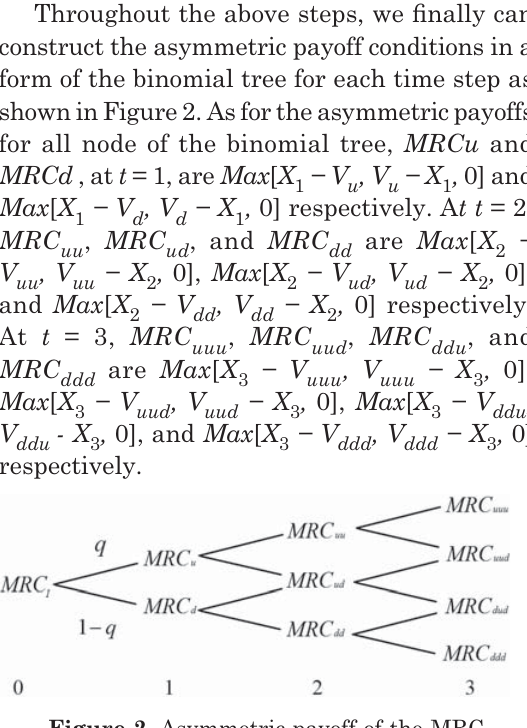
Figure 2. Asymmetric payoff of the MRC compound option in binomial